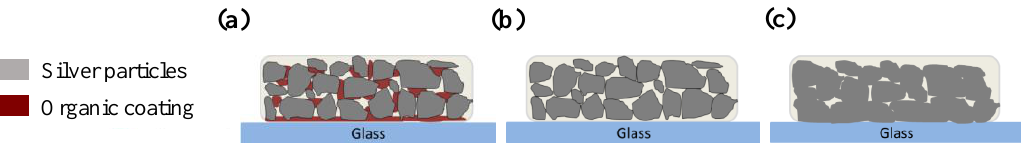
Figure 7. Schematic of the possible adhesion mechanism of ( a ) silver films based on NP ink; ( b ) silver films based on MOD ink cured in low temperature; ( c ) silver films based on MOD ink cured in high temperature.